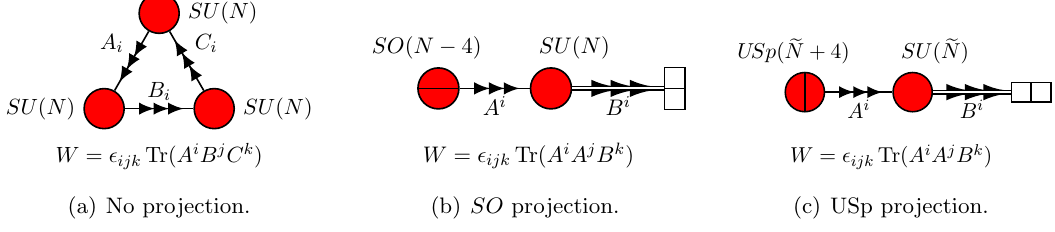
Figure 4 . (a) Quiver for N mobile D3 branes probing the C 3 = Z 3 singularity, in the absence of orientifold projection. (b) and (c) The two possibilities for the theory after orientifolding via the projection described in the